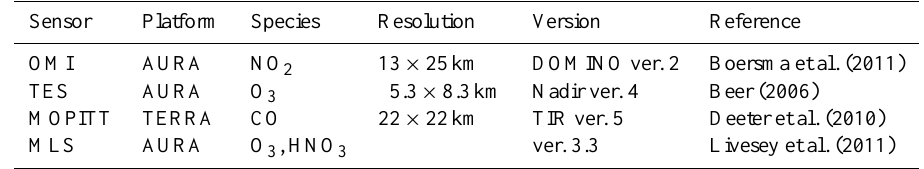
Table 1. List of satellite observations used for the data assimilation. Sensor